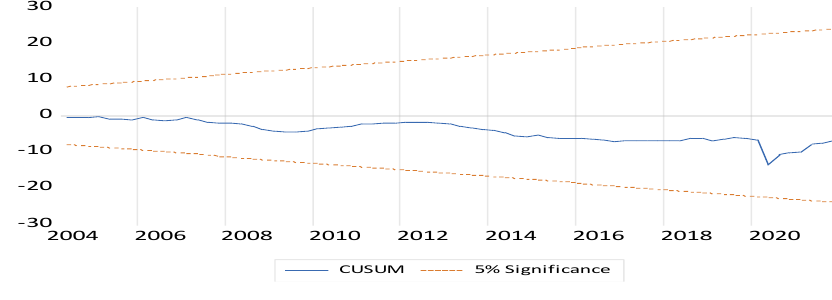
Figure 1: CUSUM test